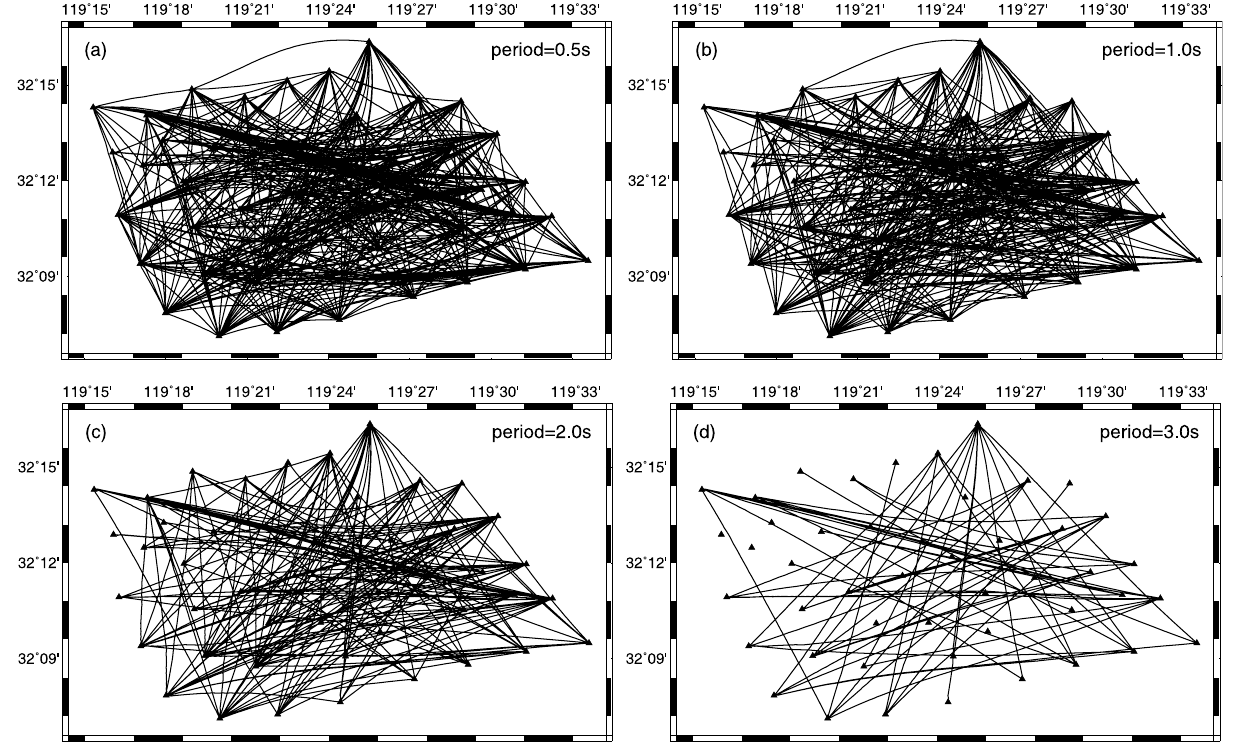
Figure 5. Ray-path coverage for four selected periods: ( a ) 0.5 s, ( b ) 1.0 s, ( c ) 2.0 s, and ( d ) 3.0 s. The triangles indicate stations, and the black lines represent ray